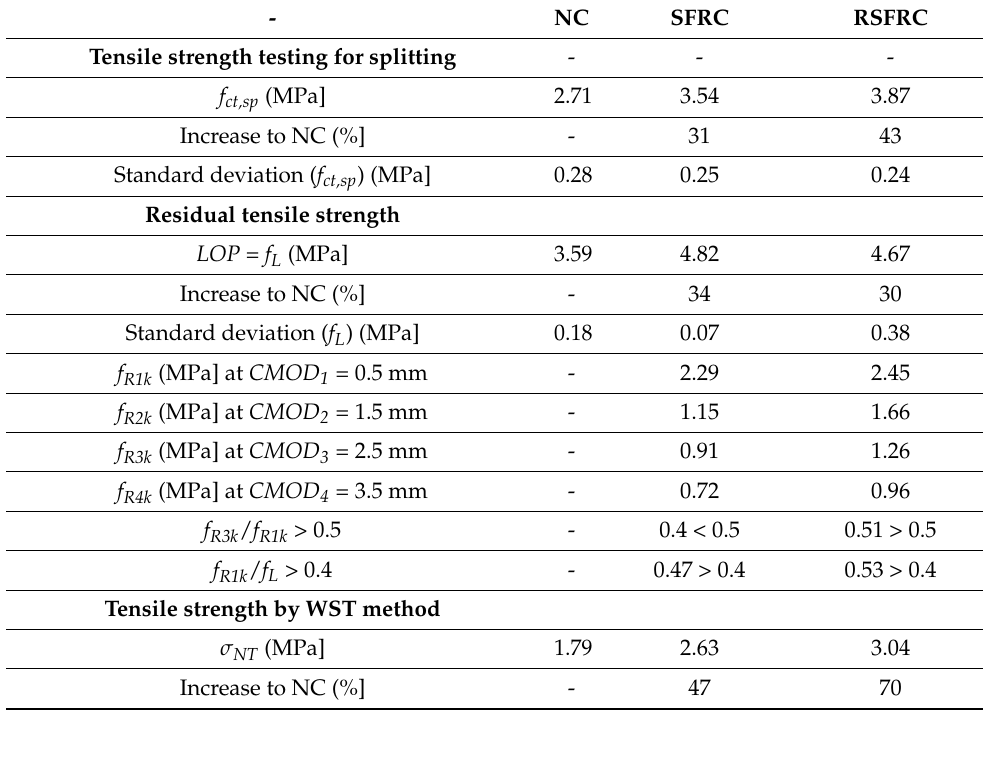
Table 5. Comparison of tensile strength for concretes without fibres (NC) and with fibres (SFRC and RSFRC).